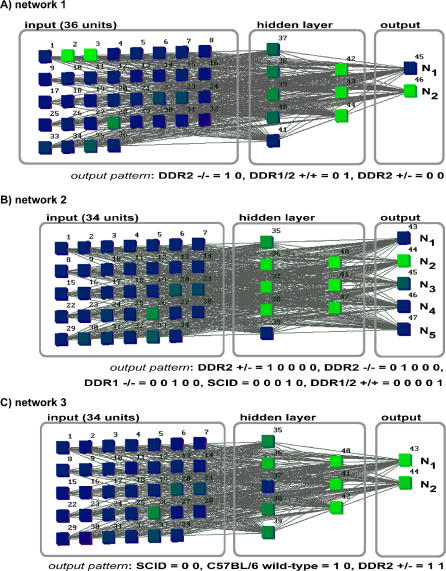
Architectures of the ANNs 1 to 3 to Discriminate DDR2−/−, DDR2+/−, DDR1−/−, DDR1/2+/+, and SCID Mice between Different Mouse Populations(A) Network 1 for paired classification classifies DDR2-deficient mice against their wild-type littermates. It consists of one input layer with 34 neurons for the skull-shape features and two additional input neurons for age and sex. The image shows the network response for a DDR1/2+/+ mouse (pattern 4, Table 2)(B) Neuronal network 2 applied for classification of all five mice strains in a mixed collective consists of one input layer with 34 neurons, two hidden layers with five and three neurons, and one output layer with five neurons N
1 − N
5. In network 2 the taught output identifies each output neuron as one mouse population. The output neuron with the highest activation is called the “winning” neuron and indicates with which class of mice the input pattern is associated. The network response for input pattern 4, the input of skull-shape features of a DDR2−/− mouse is displayed. This is demonstrated by high activation of the output neuron N
2 (green, high activation; blue, low activation).(C) Neuronal network 3 applied for classification of DDR2+/− mice, which were incorrectly identified in network 2 as C57BL/6 control mice, consists of one input layer with 34 skull-based features, one hidden layer with five neurons, and one output layer with the neurons N
1 and N
2. The output of an output unit is a value between 0 and 1. The combination of the taught output that represents a distinct phenotype of DDR2+/− and SCID or C57BL/6 wild-type mice is shown below. High activation of output neuron N
1 with simultaneous low activation of N
2 represents C57BL/6 wild-type mice, low activation of both N
1 and N
2 represents a SCID mouse, and low activation of N
1 by simultaneous high activation of N
2 represents a DDR2+/− mouse. The network response for input pattern 4, the input of skull-shape features of a heterozygous DDR2 mouse, is displayed. This is demonstrated by high activation of N
1 and N
2 (green, high activation; blue, low activation).